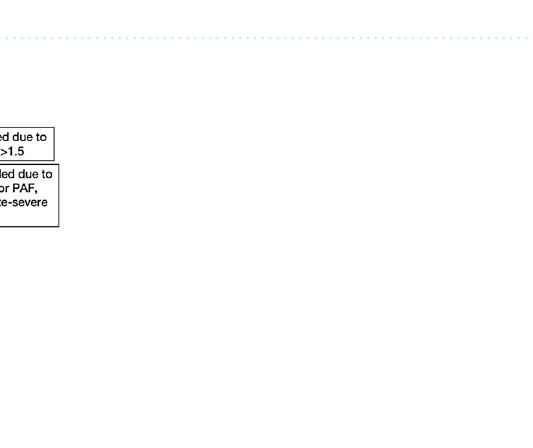
Figure 2. Flow diagram of the patient selection process. LAVI, left atrial volume index; LVEF, left ventricular ejection fraction; PAF, paroxysmal atrial fibrillation; SR, sinus rhythm; VHD, valvular heart